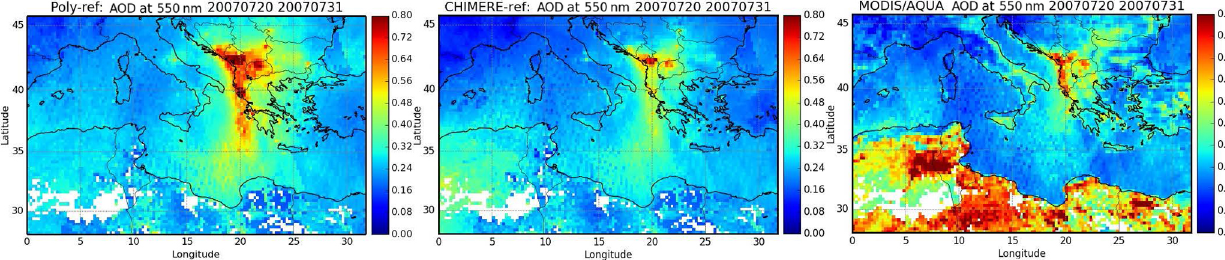
Figure 9. Mean total AOD (at 550nm) from MODIS/AQUA, Poly-ref and CHIMERE-ref during the first fire event (20–31 July